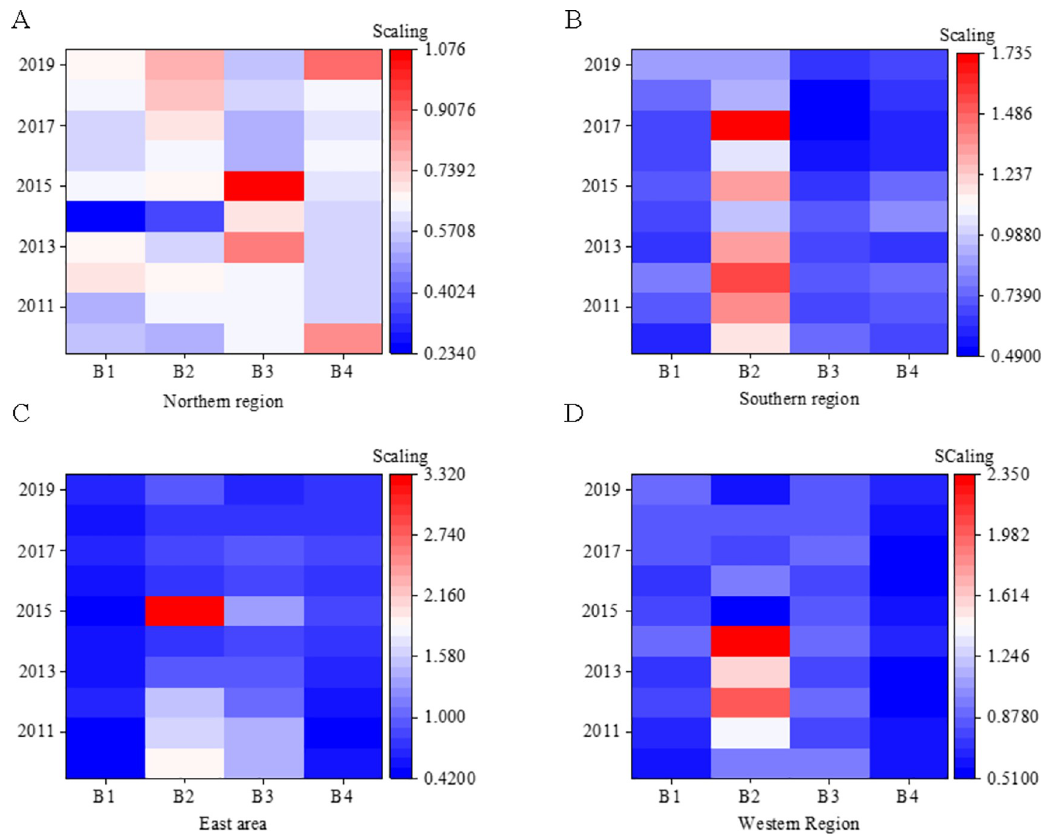
Fig 9. Super efficiency results of high-tech IDZs in different provinces and different years.